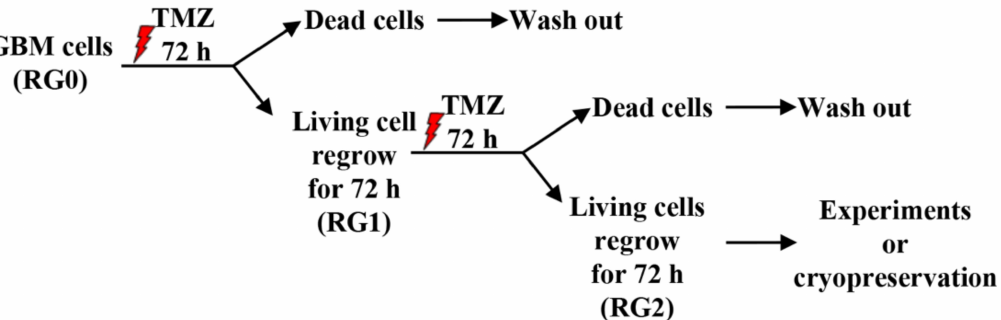
Figure 1. Schematic illustration of the acute acquired TMZ resistance model established in the present study. U373 and LN229 cells received 150 µ M of TMZ treatment for 72 h (first cycle of treatment), and thereafter the damaged cells were washed out; viable cells regrew for 72 h and were named RG1. These RG1 cells underwent the second cycle of TMZ treatment for another 72 h. Then, the medium was removed, followed by washing out with fresh medium. The living cells were kept for regrowth for 72 h and were defined as RG2. All the RG variants generated in this study were used for different experiments until passage 15. Untreated parental cells in corresponding cell lines were defined as RG0 and used as